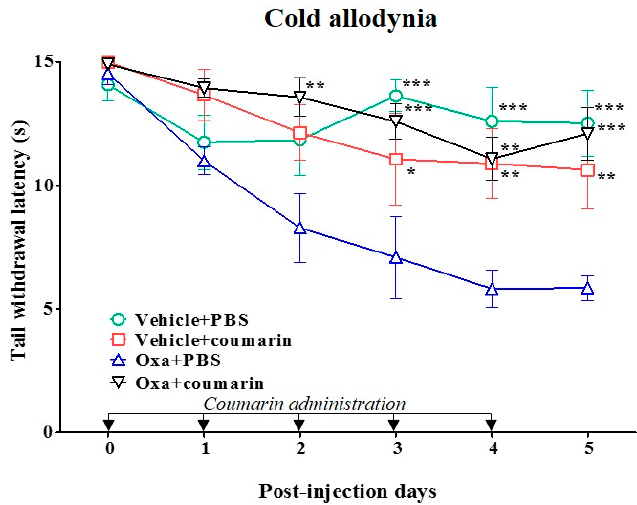
Figure 6. Anti-allodynic effect of coumarin on oxaliplatin-induced cold allodynia in rats. Animals were randomly divided into four groups ( n = 6 per group). Oxaliplatin or vehicle (5% glucose) was administered intraperitoneally on day 0. Coumarin (10 mg/kg) or PBS was administered orally for five consecutive days after injection with oxaliplatin or vehicle control. Data are presented as mean ± S.E.M.; * p < 0.05, ** p < 0.01, *** p < 0.001 vs. Oxa + PBS by two-way ANOVA followed by Bonferroni’s post-test.